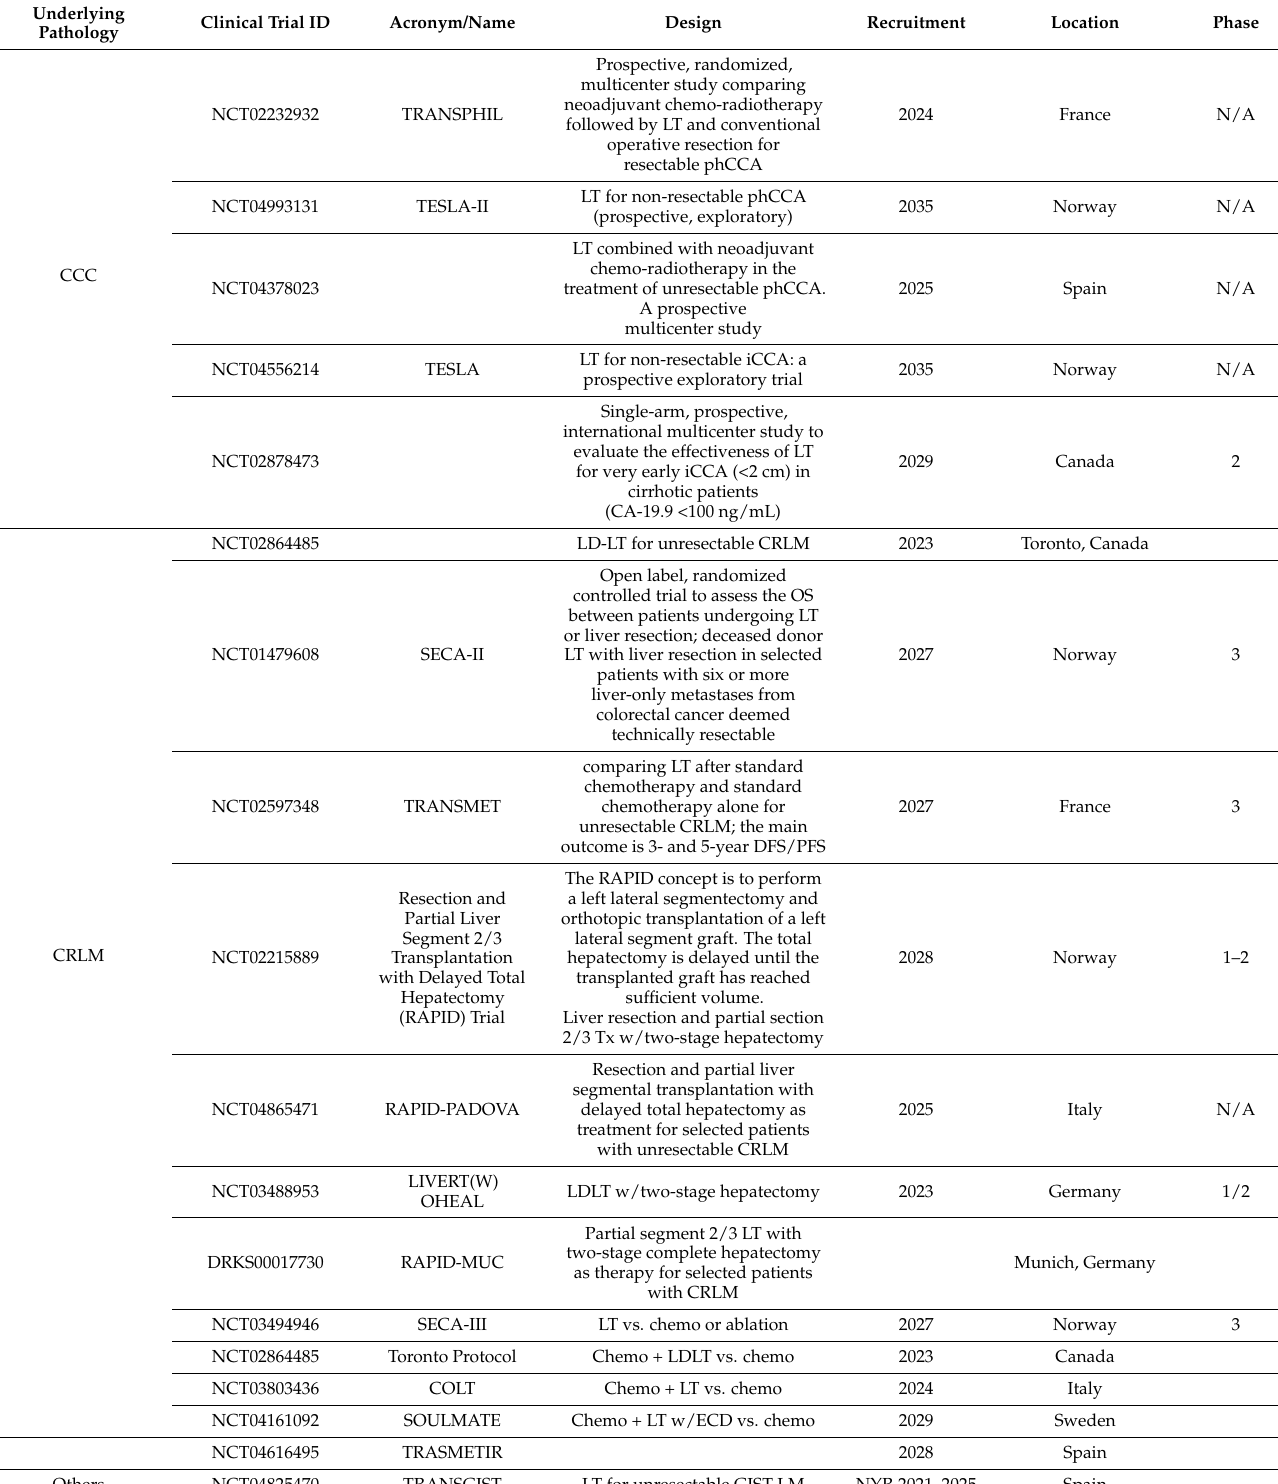
Table 1. Ongoing (surgical) studies for LT in different